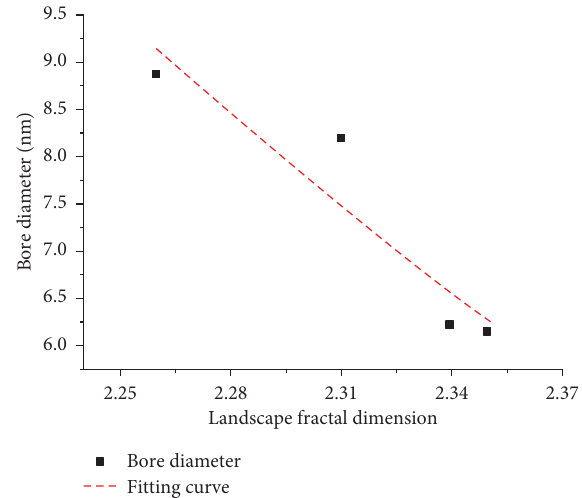
Figure 7: The relationship curves between aperture and fractal